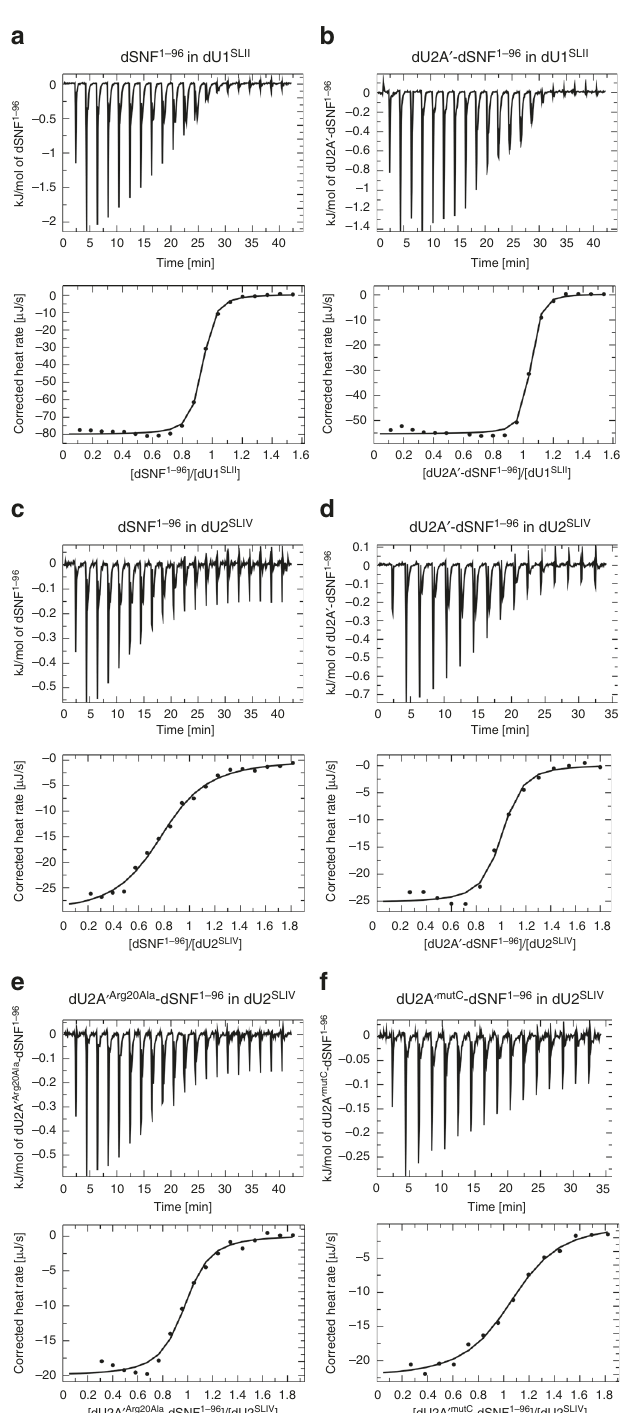
Fig. 8 ITC analysis of RNA binding by dSNF 1 – 96 or dU2A ′ – dSNF 1 – 96 . a – e Representative thermograms and binding isotherms of ITC experiments assessing the thermodynamics of binding of dSNF 1 – 96 ( a , c ), dU2A ′ – dSNF 1 – 96 ( b , d ), dU2A ′ Arg20Ala – dSNF 1 – 96 ( e ), and dU2A ′ mutC – dSNF 1 – 96 ( f ) to the indicated RNA